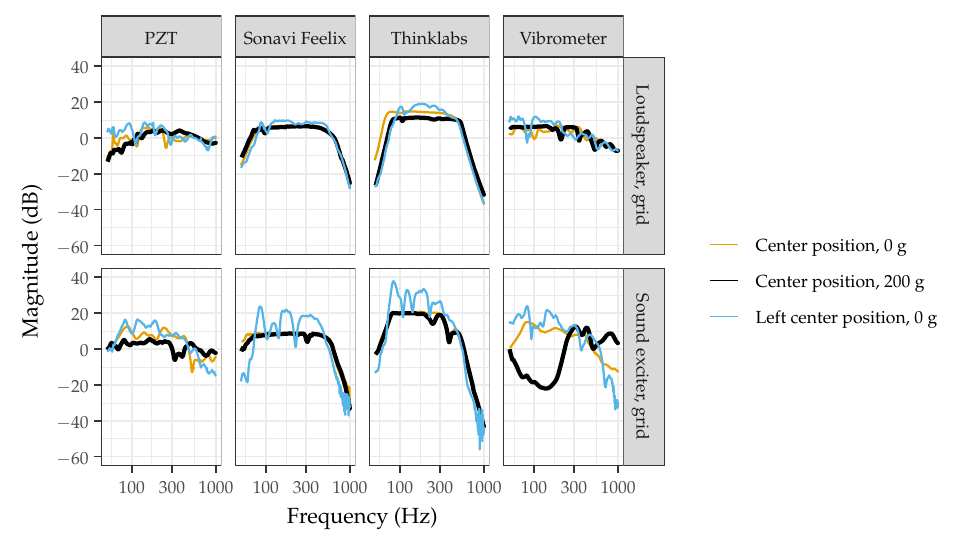
Figure 5. Frequency responses measured from a piezoelectric PZT disk, two digital stethoscopes (Feelix, Thinklabs), and vibrometer on an optimized (loudspeaker with grid support for 6 mm, type 2 gelatin) and non-optimized (sound exciter with grid support for 6 mm, type 2 gelatin) acoustic phantoms. The frequency responses are shown when measured at the center position with 0 and 200 g of added weight and at the left center position with no added weight.